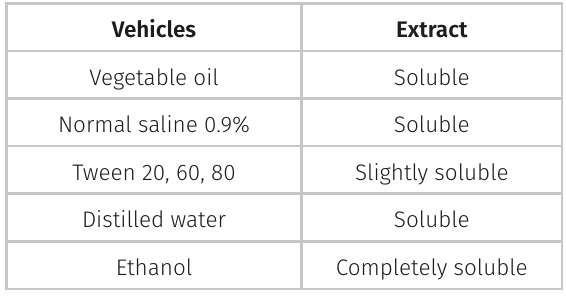
Table II. Solubility of the S. hispanica seeds extract.